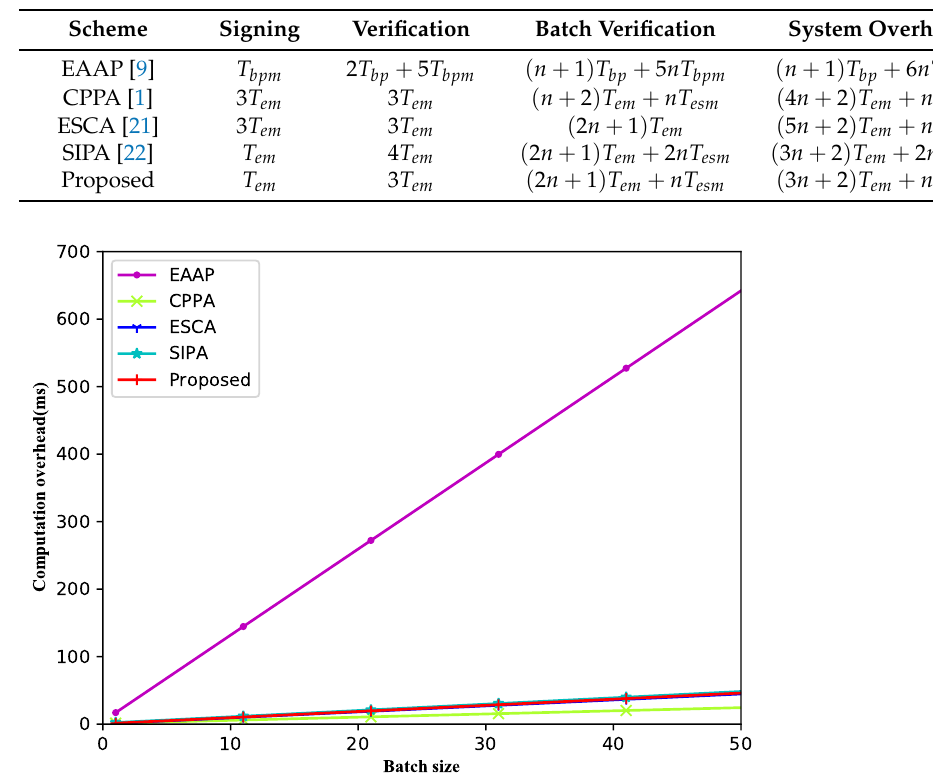
Table 1. Comparison of computation overheads.